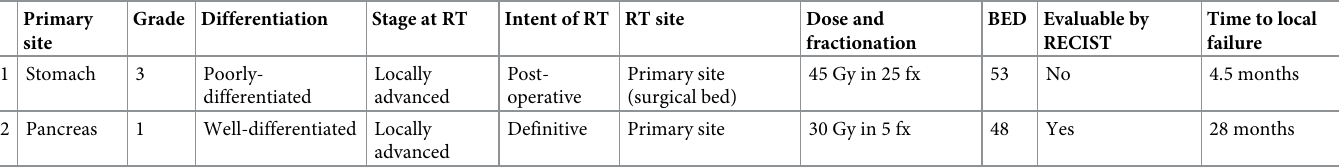
Table 3. Patient and disease characteristics of local recurrences in this study (n = 2).